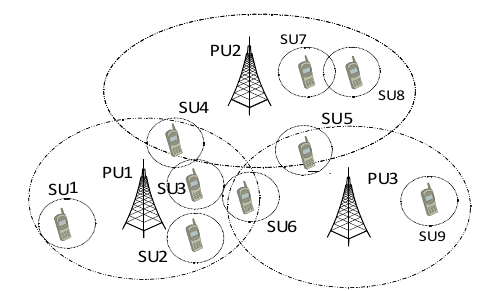
Figure 1 cognitive radio spectrum allocation